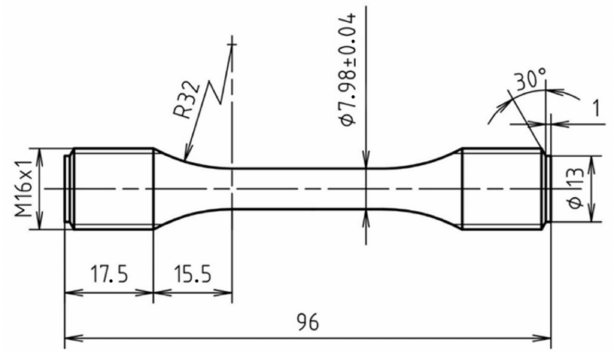
Figure 2. Technical drawing of specimens designed for fatigue